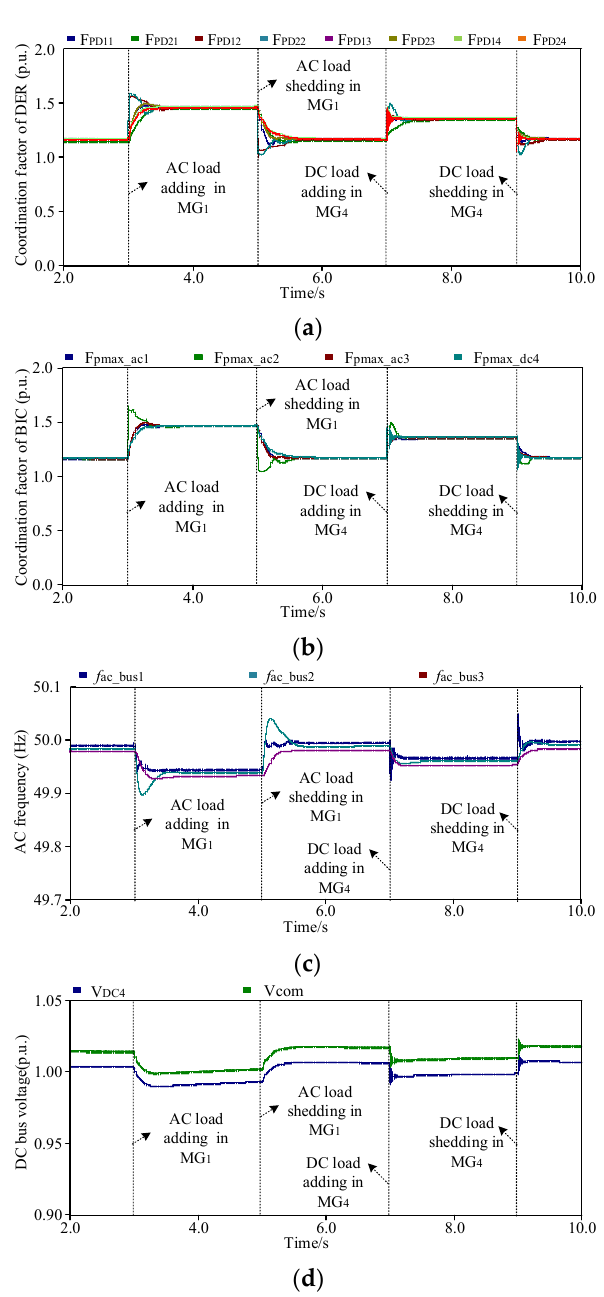
Figure 14. Performance of proposed strategy under regular load fluctuations: ( a ) Output power of AC/DC DERs, ( b ) Output power of BICs, ( c ) Frequencies of AC MGs, ( d ) Voltages of common bus and DC MG.